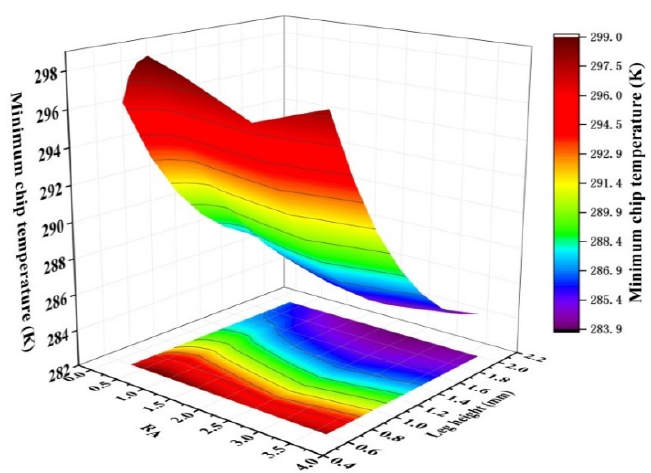
Figure 9. Variation of the minimum chip temperature with cross-sectional area ratios of the cold to hot ends of the legs and leg heights.